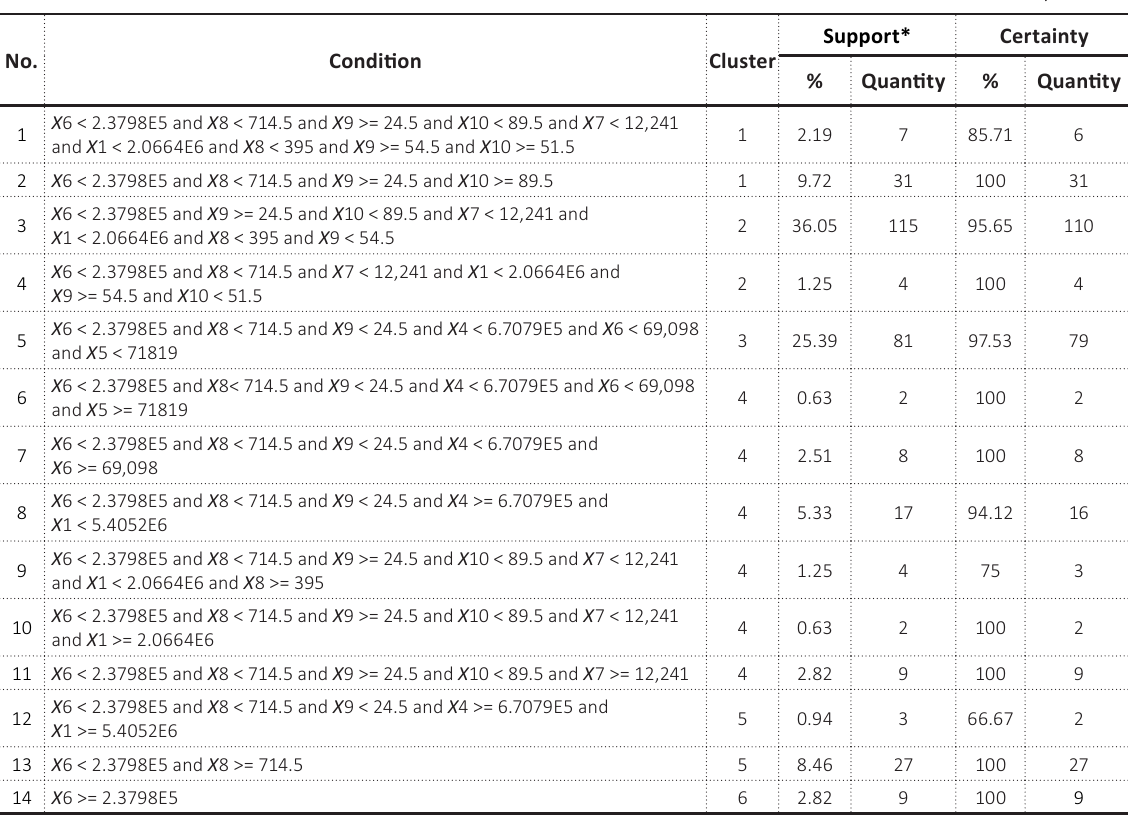
Table 2. Classification rules of a country’s membership in a particular cluster and assessment of the model’s accuracy